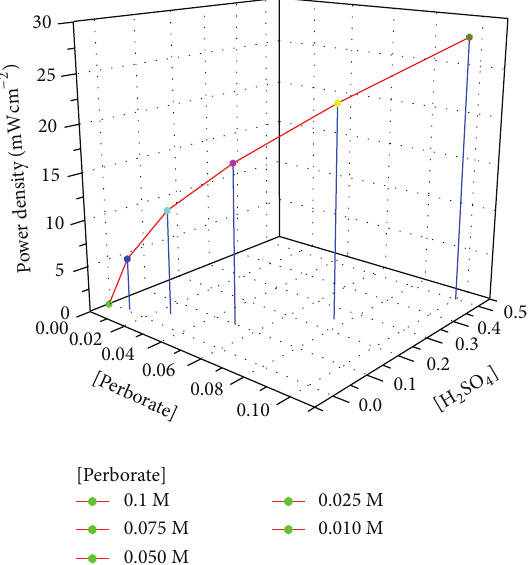
Figure 7: Effect of various combinations of perborate and sul- phuric acid concentrations on the maximum power density (28.2 mWcm −2 ) of the MLSPBFC at room temperature. The fuel mixture for variation of oxidant is ([fuel]: 2 M formic acid + 0.5 M NaOH, [oxidant]: 𝑥 M perborate + 0.5 M H 2 SO 4 ) and the fuel mixture for variation of sulphuric acid is ([fuel]: 2M formic acid + 0.5 M NaOH, [oxidant]: 0.1 M perborate + 𝑥 M H 2 SO 4 ). Stream flow rates: 0.3 mL min −1 .